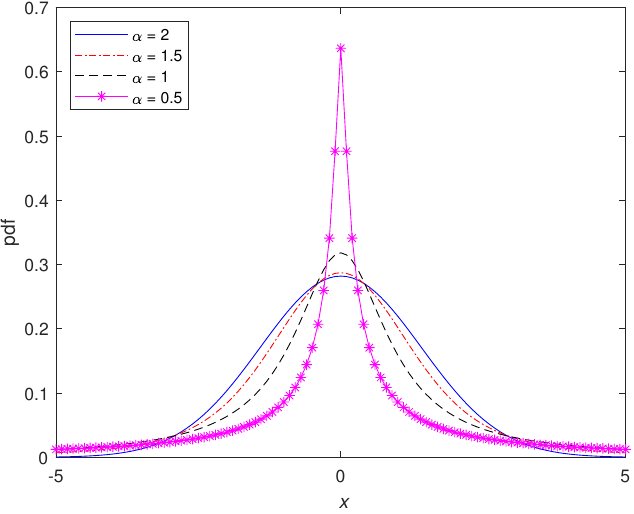
Figure 2. Pdf of symmetric α -stable distributions for the different α